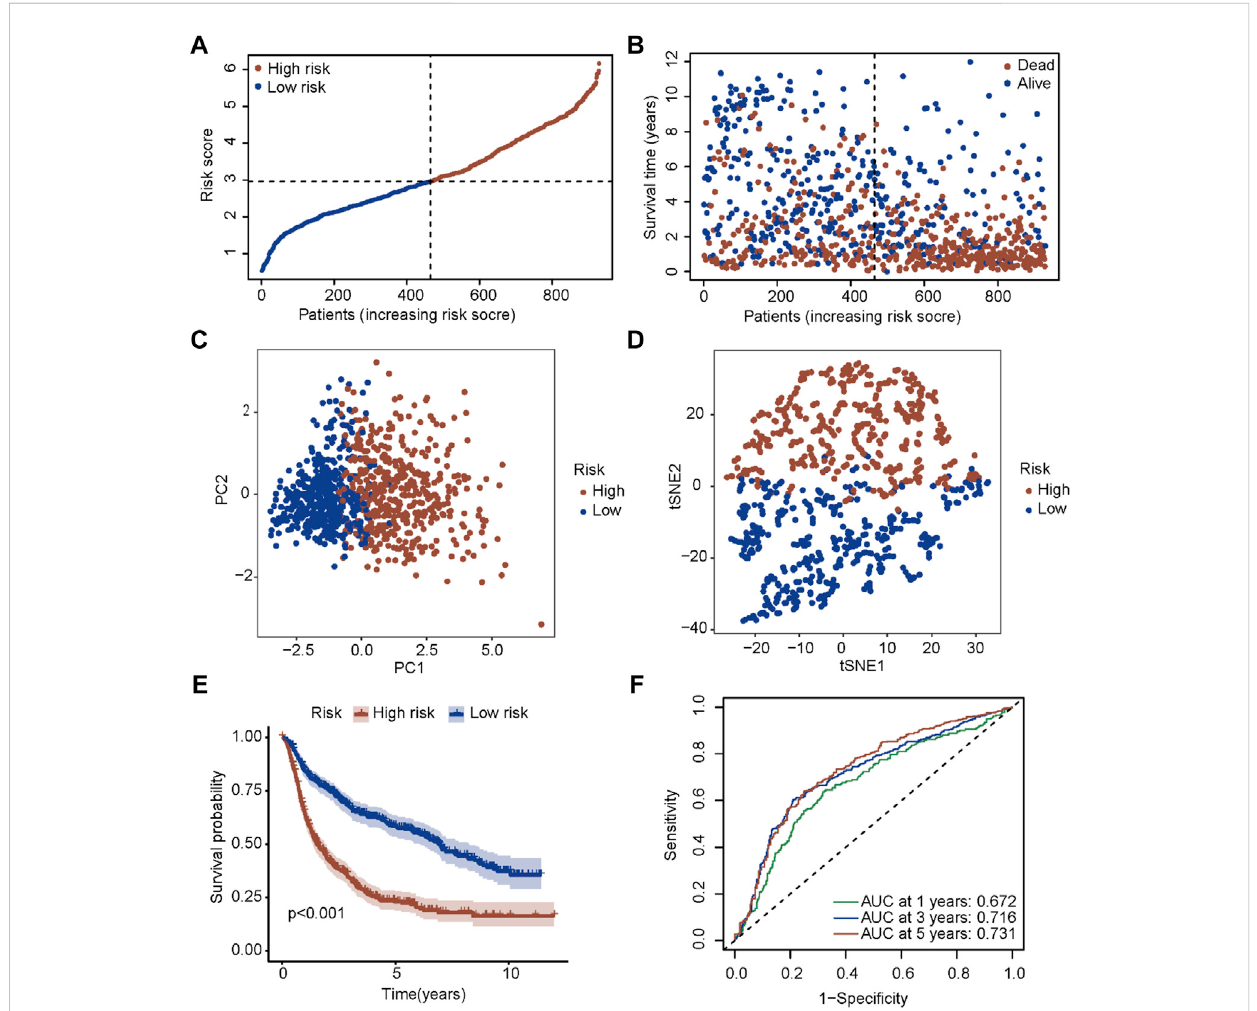
FIGURE 5 Validation of the fi ve-gene signature in the CGGA cohort. (A) The distribution and median value of the risk scores in the CGGA cohort. (B) The distributionsofOSstatus,OStimeandriskscoreintheCGGAcohort. (C) PCAplotoftheCGGAcohort. (D) t-SNEanalysisoftheCGGAcohort. (E) Kaplan- Meier curves for the OS of patients in the high-risk group and low-risk group in the CGGA cohort. (F) AUC of time-dependent ROC curves in the CGGA